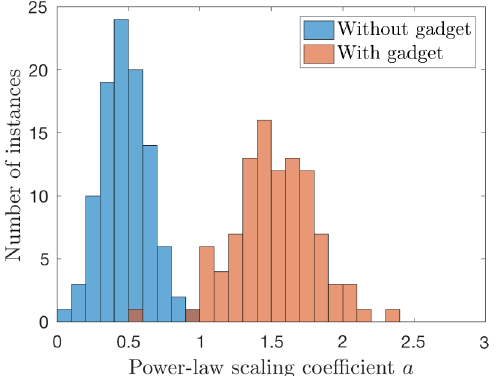
FIG. 7. Empirical scaling behavior with and without the gadget. Shown is the distribution of the power-law scaling coefficient a b for 100 instances at obtained after fitting ln p to a ln t S f þ ∈ ½ 5 ; 50 (cid:2) μ s L ¼ 16 , run on the DW2KQ processor. We choose t f since this is the range over which the TTS decreases, as seen in Fig. 1(a). The instances with the gadget typically exhibit a larger scaling coefficient, which leads to the observation of an optimal annealing time. In (a) and (b) error bars represent 95% confidence intervals ( 2 σ ) calculated using 1000 bootstraps of 100 gauge transformations